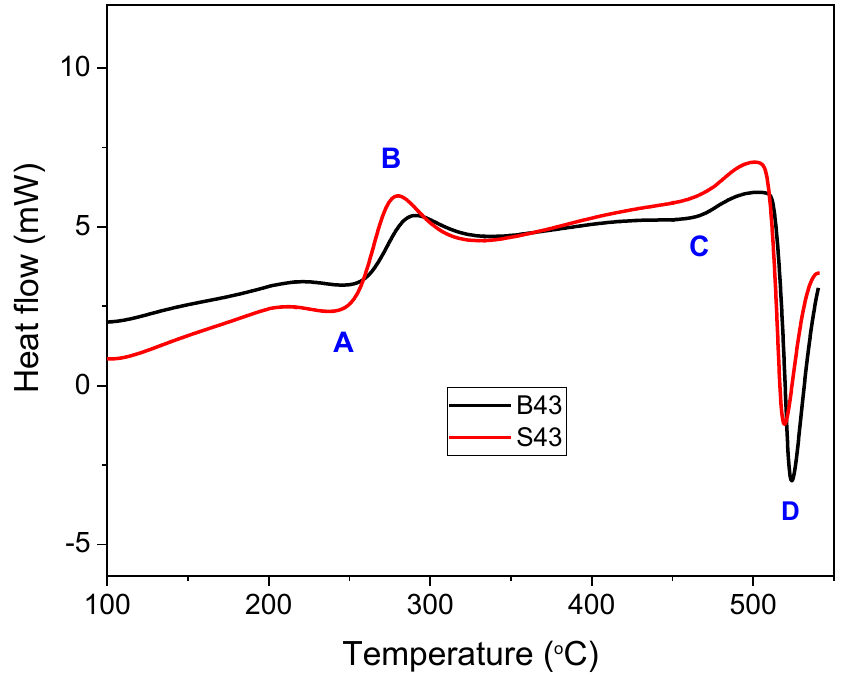
Figure 9. DSC curves of the investigated alloys, which were heated at a rate of 10 °C per minute.